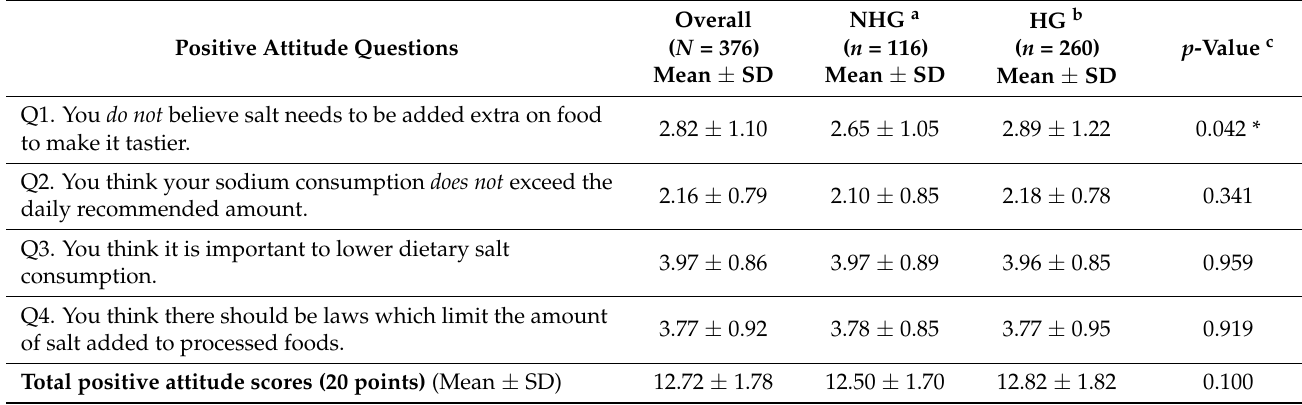
Table 3. Dietary-salt-related attitudes associated with